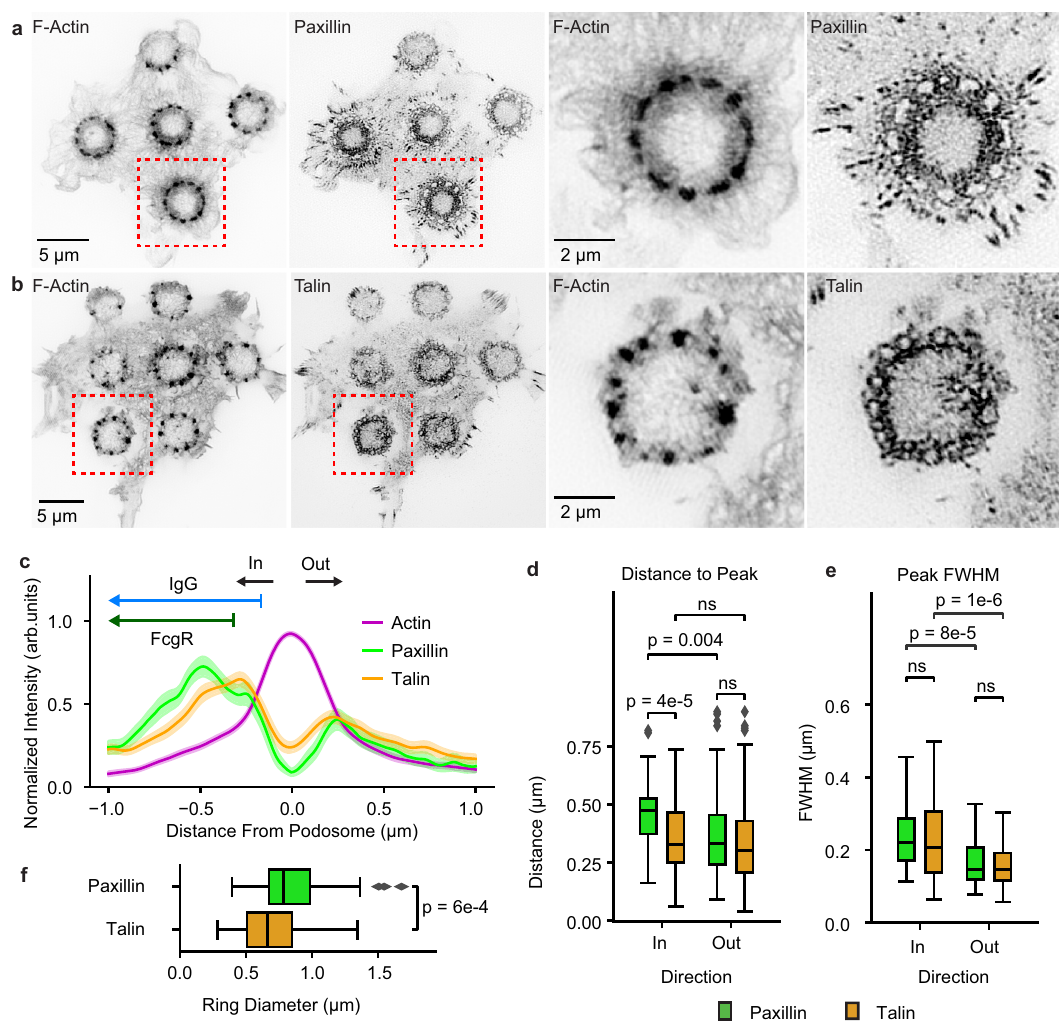
Fig.7|Relativepositionsofpodosomeactincoreandotherproteins.a , b TIRF- SIM images of F-actin (lifeact-Halo-549), paxillin-EGFP ( a ), and talin- EGFP ( b ) in RAW 264.7 macrophages plated on disks of micropatterned IgG-Alexa 647. c Perpendicularline scansforF-actin, paxillin, and talinwith podosome